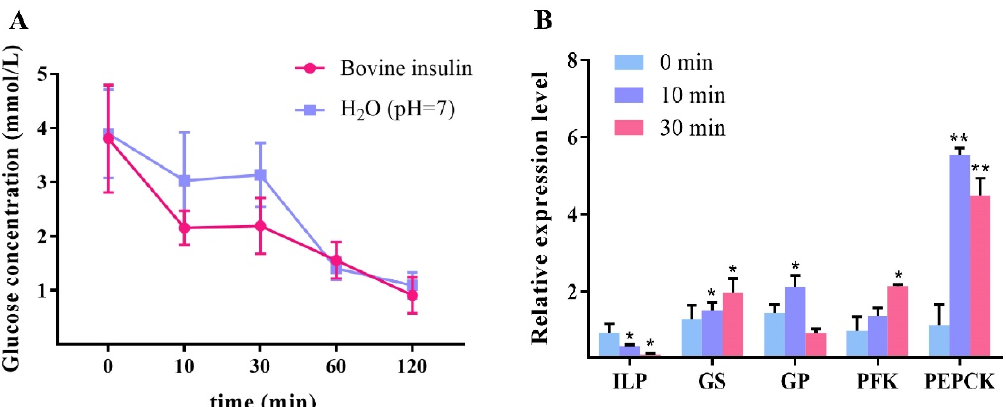
Figure 3. Effects of bovine insulin injection on hemolymph glucose and the expressions of LvILP and glucose metabolism genes. ( A ) The variation curve of hemolymph glucose concentration of L. vannamei after in vitro injection with bovine insulin. ( B ) Changes of the relative expression levels of LvILP , GS , GP , PFK , and PEPCK at 0 min, 10 min, and 30 min after injection with bovine insulin. The expression levels of the genes were detected by RT-qPCR, and 18 S rRNA was used as an internal reference. Error bars indicate the mean ± SD of three replicate samples. Statistical significances are shown as * p < 0.05 and ** p <